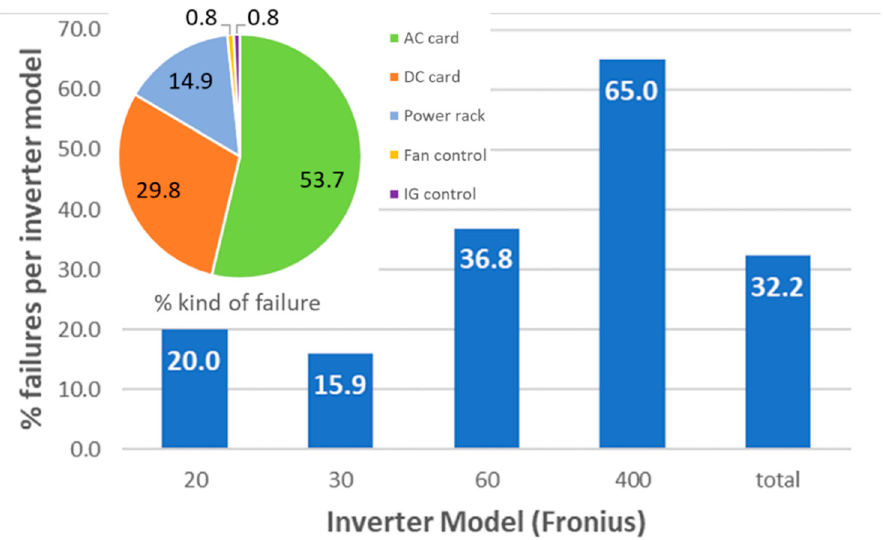
Figure 13. Percentage of inverters of each Fronius model with failures (after ten years of operation) in 99 sectors, with a total of 279 inverters in the Yéchar Solar plant. The inset pie chart shows the share of every kind of failure.